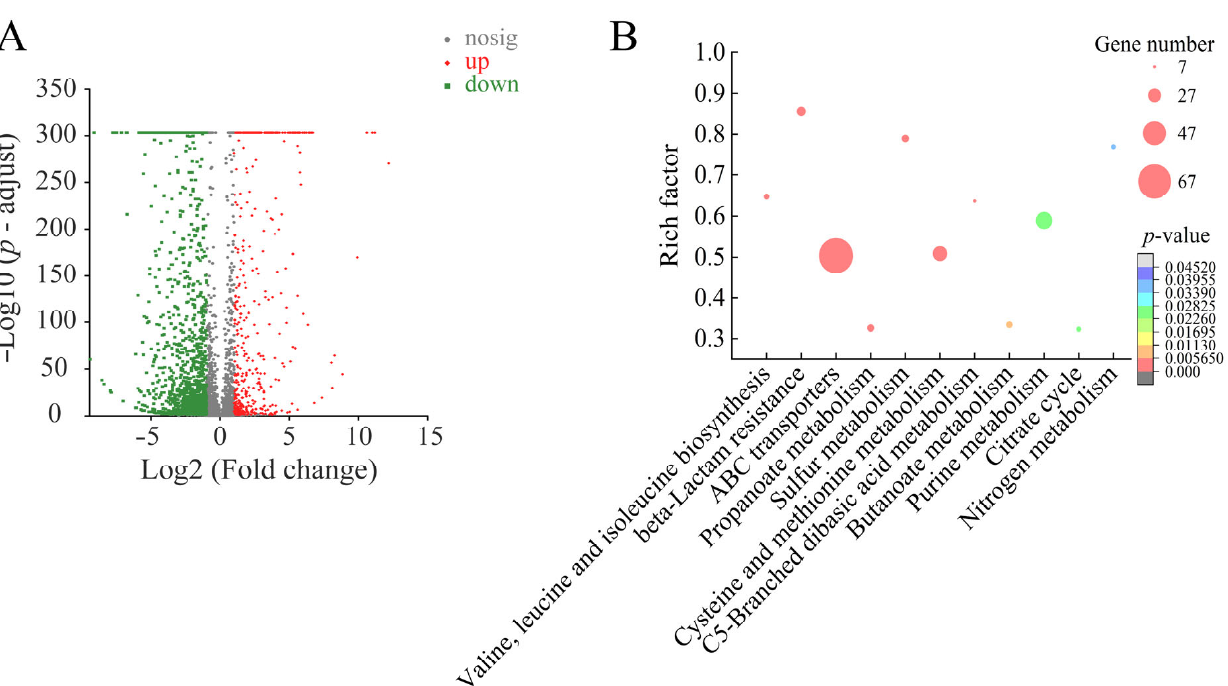
Figure 8. The 11 significantly altered metabolic pathways in B. cereus A1-1 mediated by Fragment 1 from C. communis Linn. ( A , B ) Volcano plot of differential gene expression and significantly changed metabolic pathways in the bacterium.